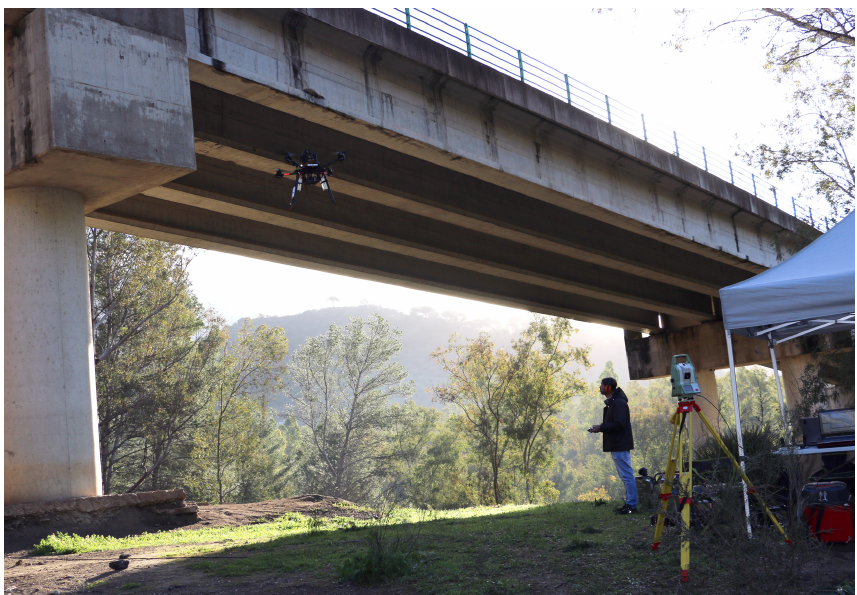
Figure 1. Aerial robots are becoming more relevant for industrial applications in GNSS-denied or GNSS-degraded